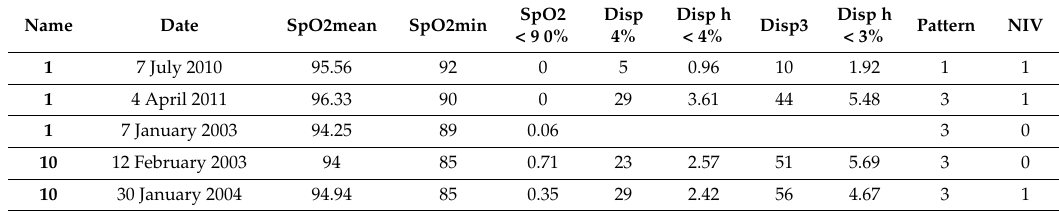
Table 9. NPO output table; generated using NPO and demographics (NIV) original input information.